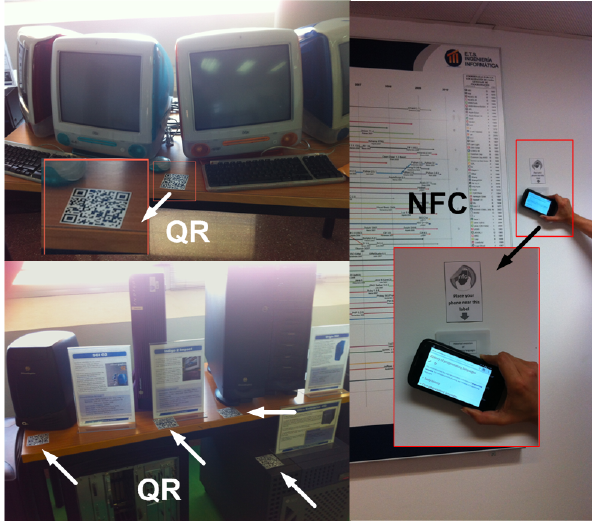
Figure 11. Snapshot of QR tags on exhibits. Snapshot of NFC tag on a panel located in a